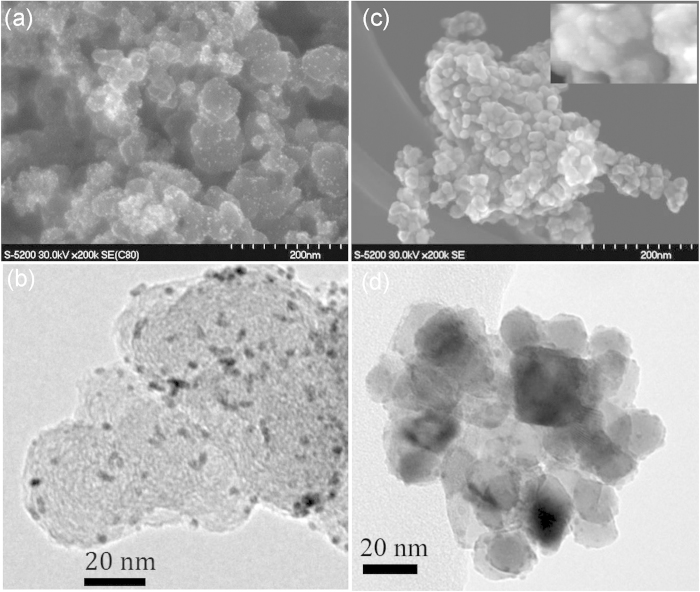
SEM images of (a) Pt/C and (b) Pt/SnO2. The inset image shows Pt nanoparticles on SnO2 at higher magnification. Typical TEM images of (c) Pt/C and (d) Pt/SnO2.